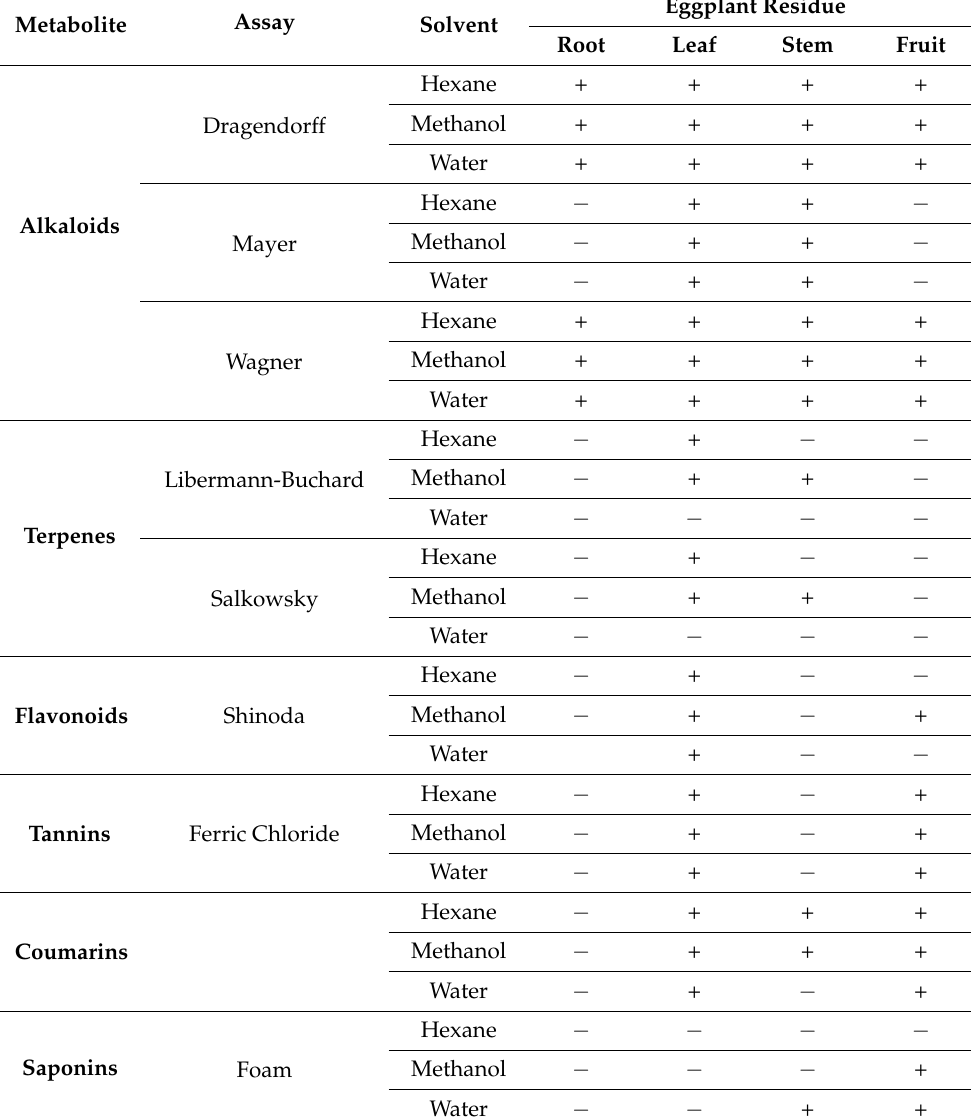
Table 1. Phytochemical screening of eggplant agricultural residues. (+) Presence; ( − ) absence. Metabolite Assay Solvent